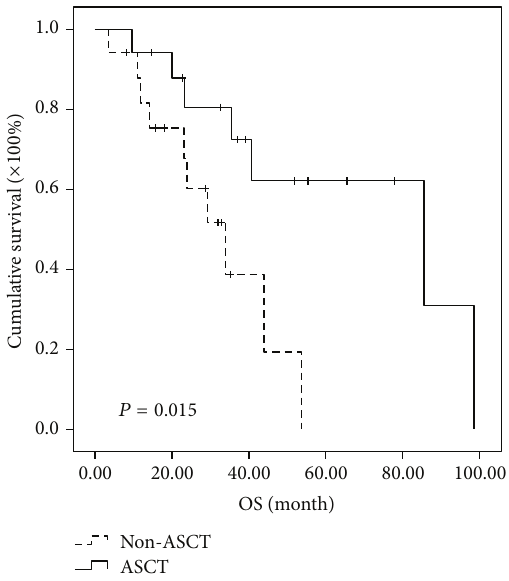
Figure 6: Comparison of OS in the patients of ASCT group and non-ASCT group in the intermediate-risk subgroup. Themedian OS was54versus42.1monthswithnosignificantdifference( 𝑃 = 0.932 ).